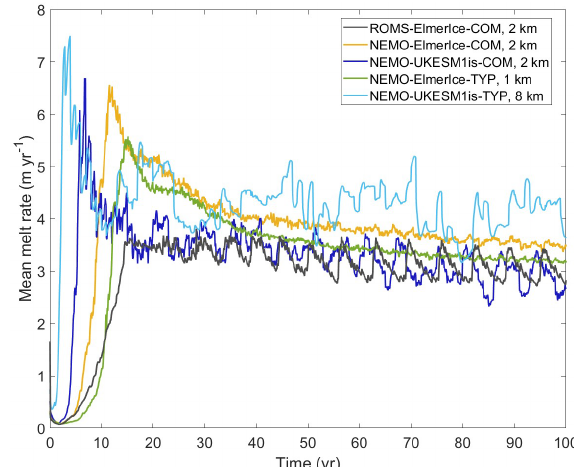
Figure A8. Simulated mean melt rates from different coupled